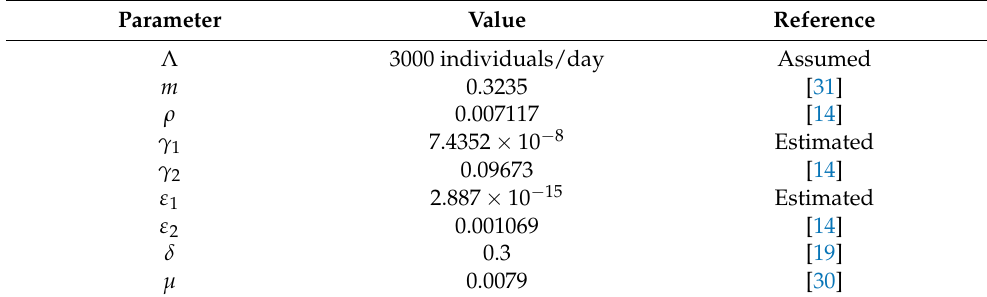
Table 2. The value of each parameter in the SVIHR model for the dynamic simulation to investigate the long-term behavior.